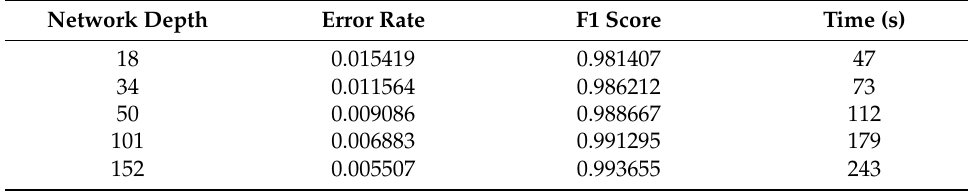
Table 9. Network depth on validation split = 20.